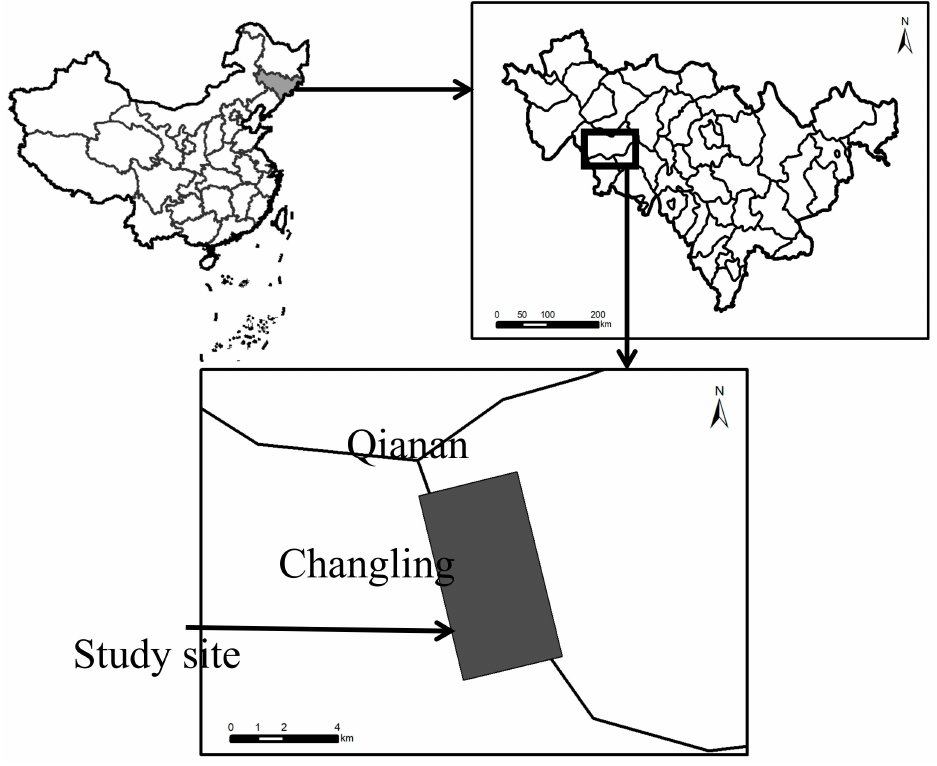
Figure 1. Location of the study